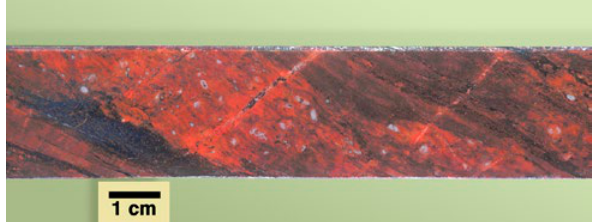
Figure 20. Formerly fluid (thixotropic) jasper band were found in the lode section when drilling the Explorer 7 prospect at Tennant Creek, NT. During flow the fluid jasper gel developed denser accre- tions of paler ‘blue’ (leucoxene tinged) and white quartz (From Elli- ston 9 , 2017, p.159).